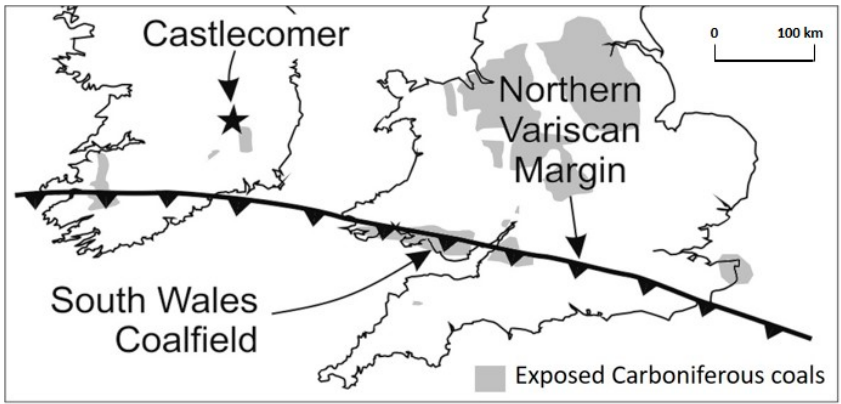
Figure 2. Setting of the Leinster Coalfield and South Wales Coalfield as basins north of the Variscan belt, modified from [33]. Gold associated with selenides, pyrite and siderite nodules have been previously recognised in the South Wales Coalfield [12,13,34], while Castlecomer coals of the Leinster Coalfield (sample area indicated by black star) are both pyritic and contain abundant siderite nodules [35].